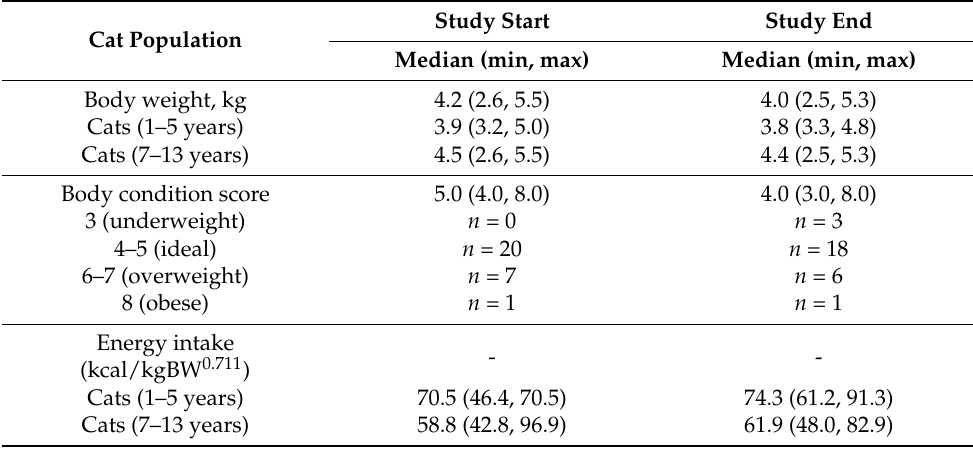
Table 4. Description of the cat